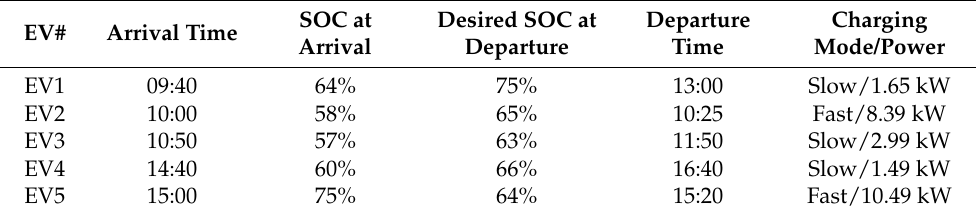
Figure 21. ( a ) EVs charging power and EVs SOC evolution for Scenario 2c; ( b ) EVs charging power and EVs SOC evolution for Scenario 2d.